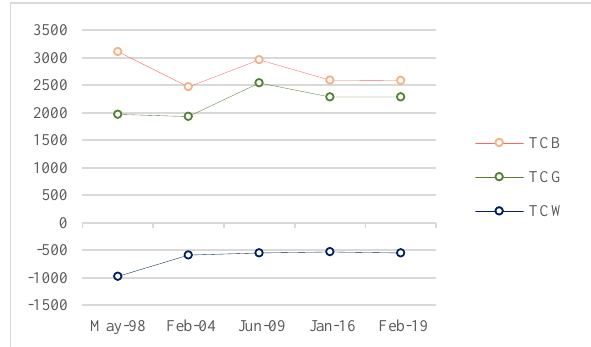
Figure 5. Trends of Tasseled Cap Indices from 1998 to 2019 Greenness values for the past 21 years were also decreasing. The peak mean TCG value was in 2009 at 2541.694, while the lowest was in 2004 at 1930.592. TCG values represent the greenness of the pixels of the image. A higher degree of greenness denotes more photosynthetically active vegetation (Tasseled-Cap Transformation, 2012).